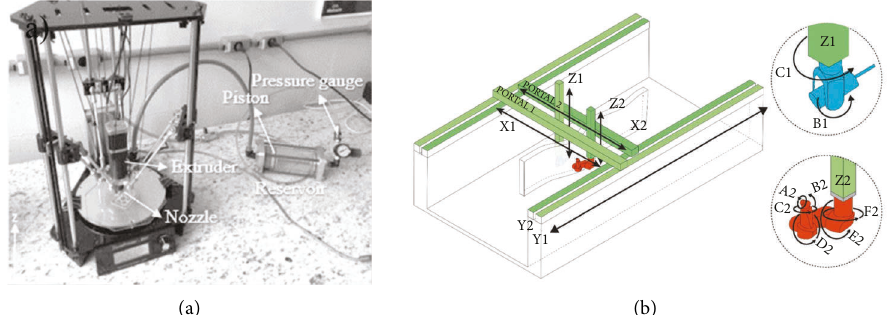
Figure 5: Multi-degree of freedom frame (a) [14] and multi-degree of freedom sprinkler head device (b) [17].